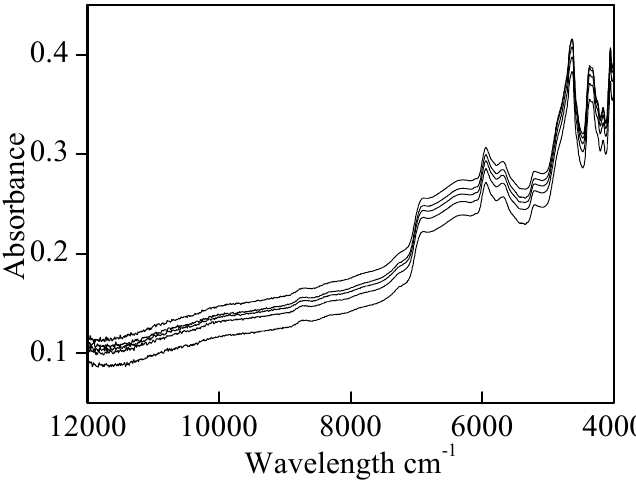
Figure 4. On-line near infrared spectra of the prepreg with different contents during the manufacture.